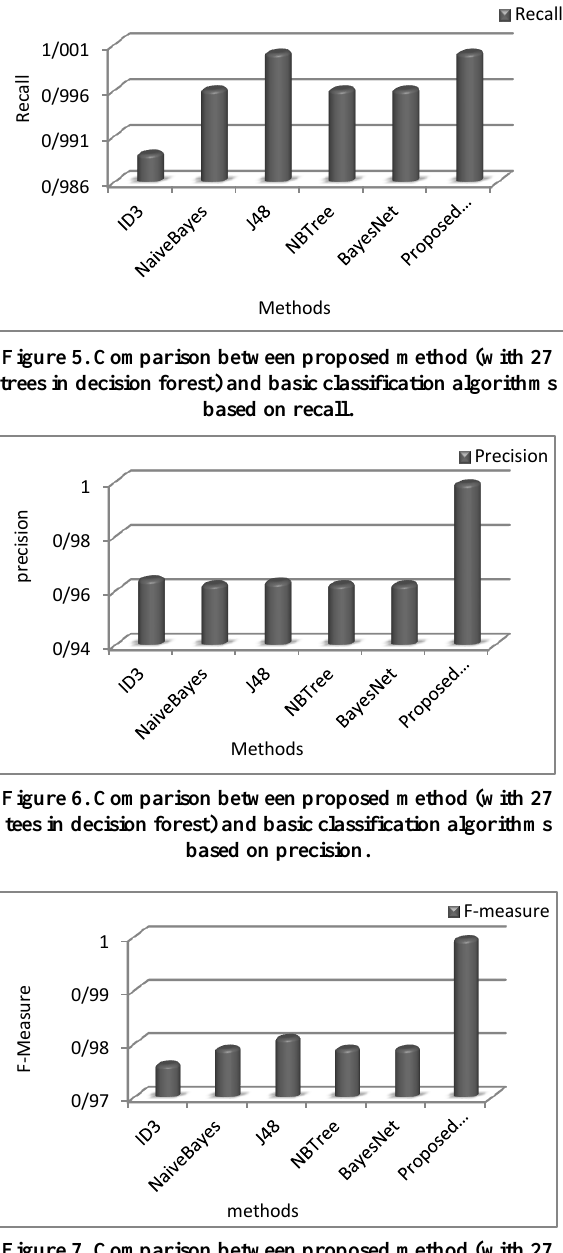
Figure 7. Comparison between proposed method (with 27 tees in decision forest) and basic classification algorithms based on